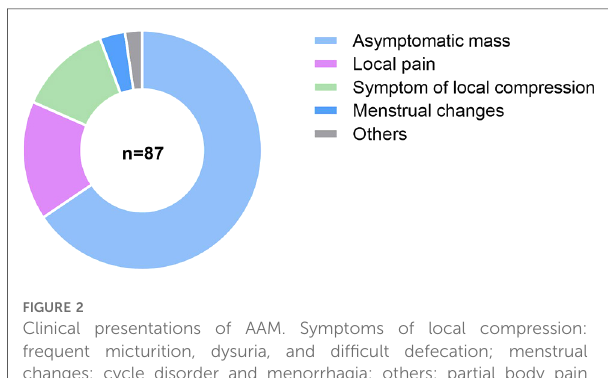
FIGURE 2 Clinical presentations of AAM. Symptoms of local compression: frequent micturition, dysuria, and dif fi cult defecation; menstrual changes: cycle disorder and menorrhagia; others: partial body pain and breathing dif fi